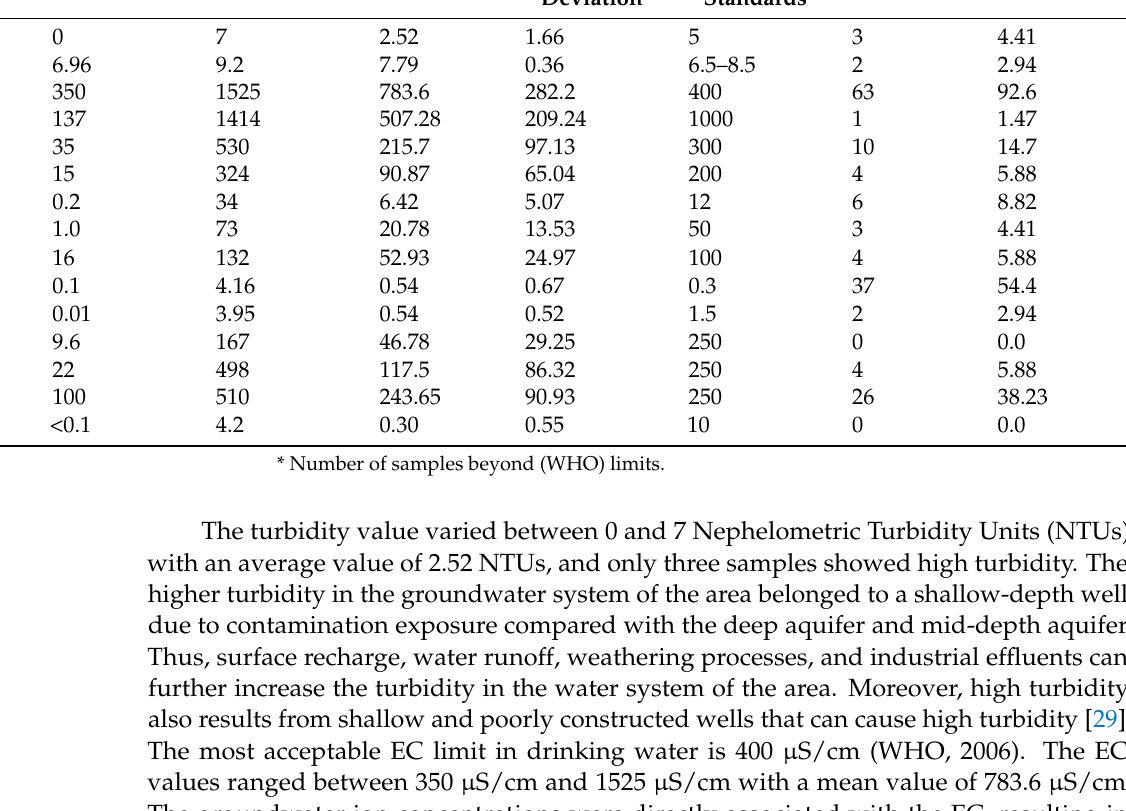
Standard WHO NSBL * NSBL % Deviation Standards